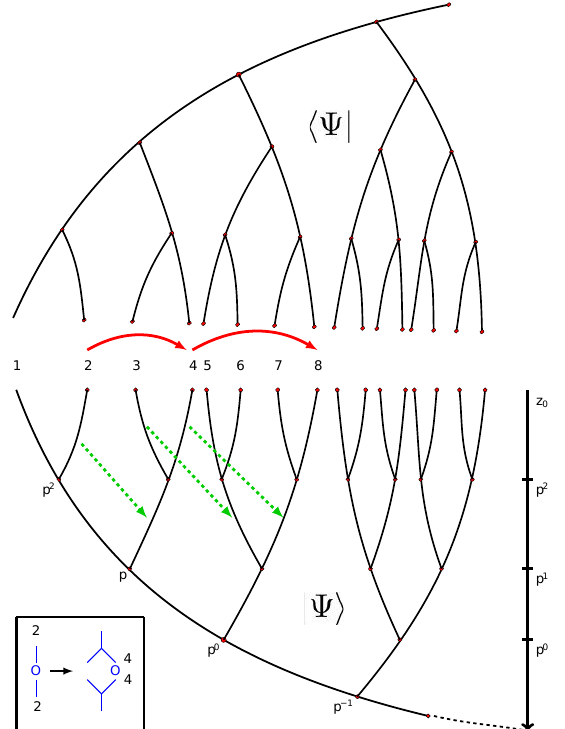
Figure 8. A tree tensor network together with its conjugate, glued together (in computation of correlators) along the common boundary, which is the analogue of the Poincar(cid:19)e cuto(cid:11) surface in the BT tree. Tensors move down the tree under a scaling transformation. We indicate with green arrows a few examples of how the links move. Such a transformation corresponds to a transformation of operators such that it is sandwiched between a network tensor. This is depicted in the